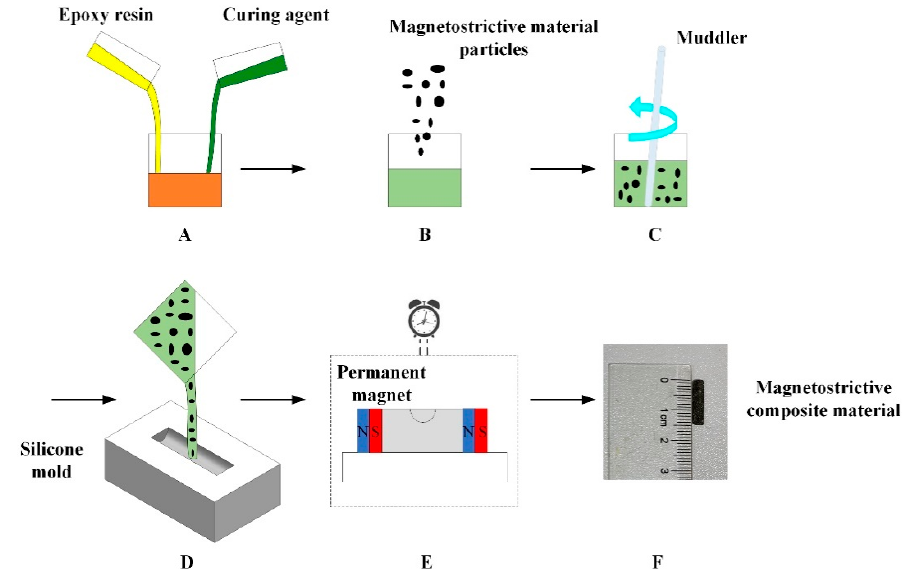
Figure 5. The manufacturing procedure of magnetostrictive composites. ( A ) a measured volume of hardener was added to epoxy resin. ( B ) a Terfenol-D powder was introduced. ( C ) the whole mixture was intensively stirred. ( D ) the mixture was poured into silicone mold. ( E ) the silicone mold with the mixture was subjected to polarization. ( F ) the semi-cylindrical magnetostrictive composite was obtained.